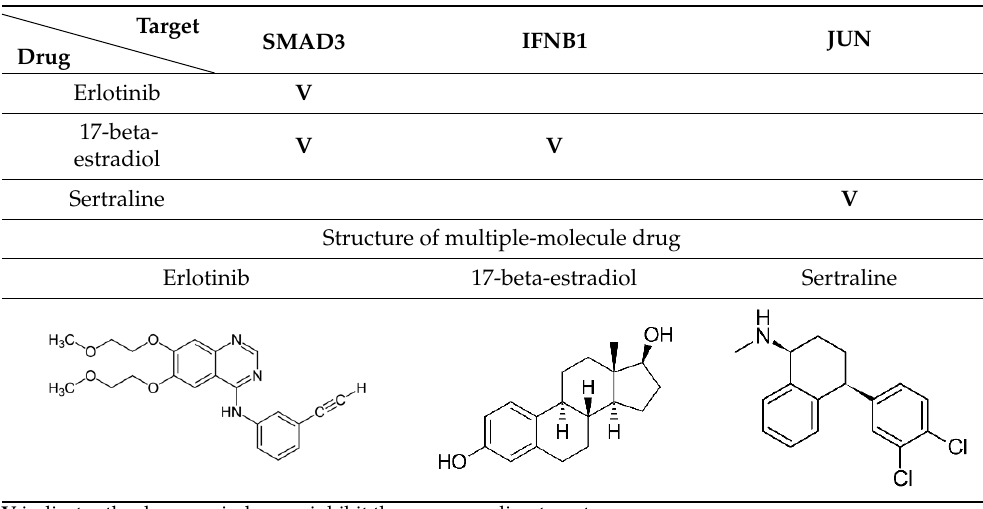
Table 7. The proposed potential multiple-molecule drug with the corresponding targets for shortening the course of the saturation stage of SARS-CoV-2 infection.